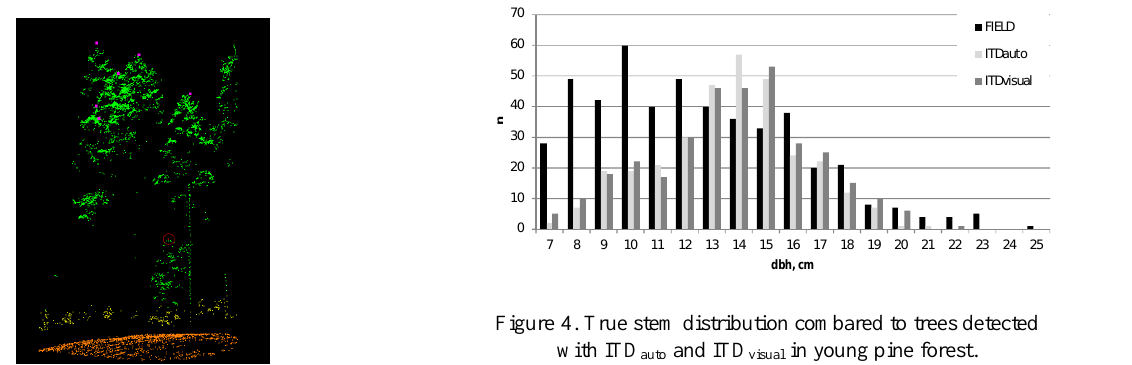
Figure 2. Commission errors reduced in visual interpretation. Purple dots represent automatically detected trees as blue ones are visually corrected trees.